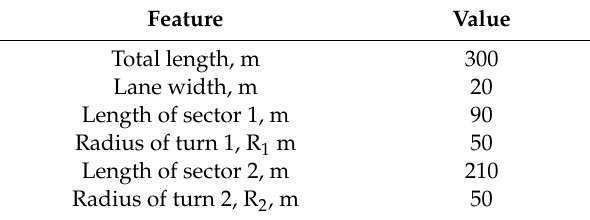
Table 2. Main features of the test track.